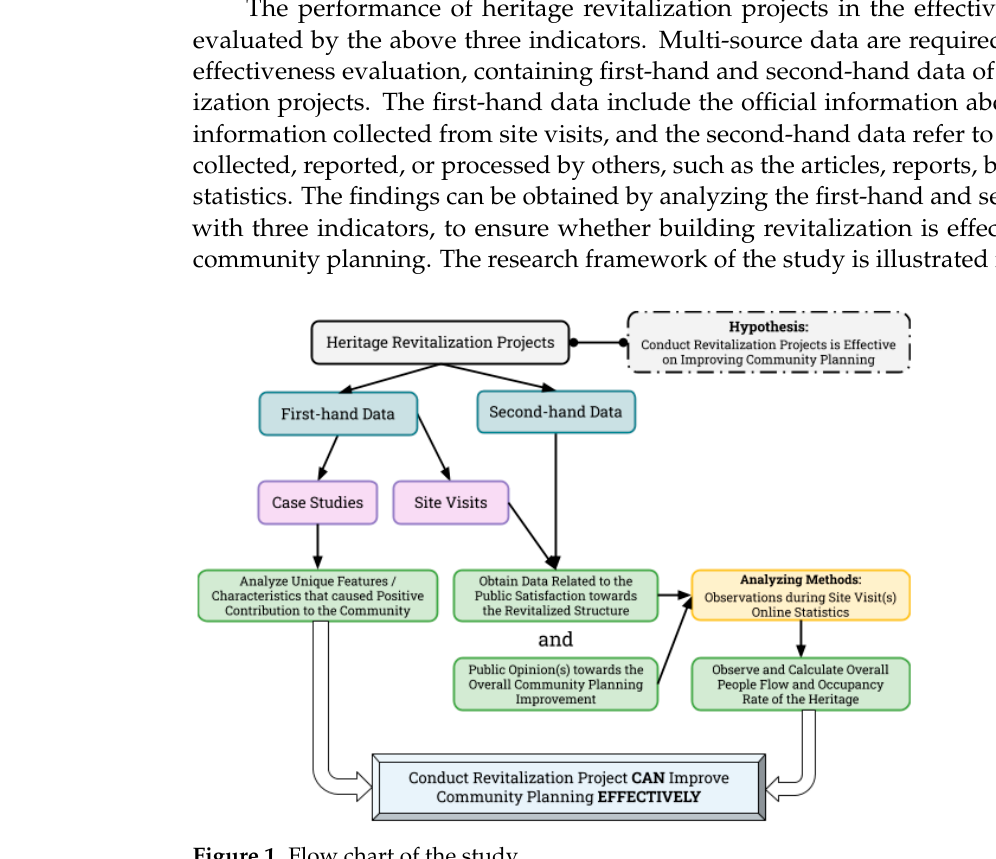
Figure 1. Flow chart of the study.